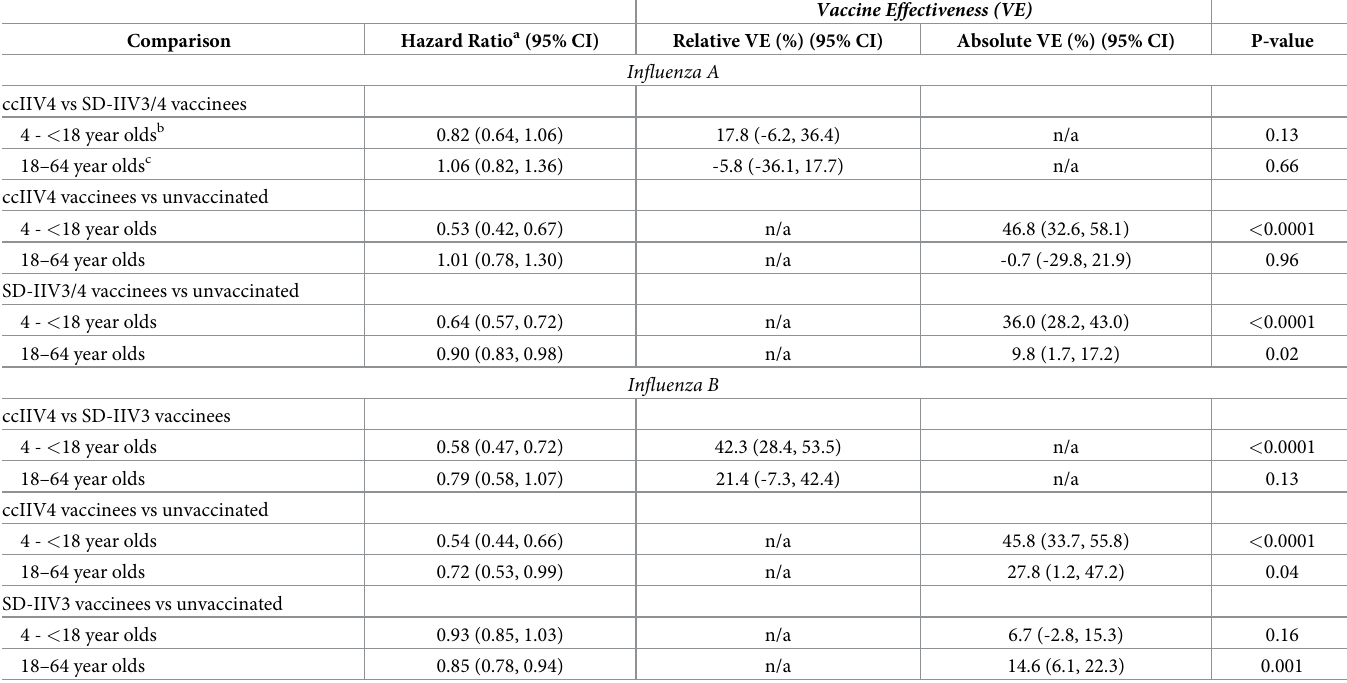
Table 4. Vaccine effectiveness of cell culture and egg-based inactivated influenza vaccines against influenzas A and B stratified by age, Kaiser Permanente Northern California 2017–18.